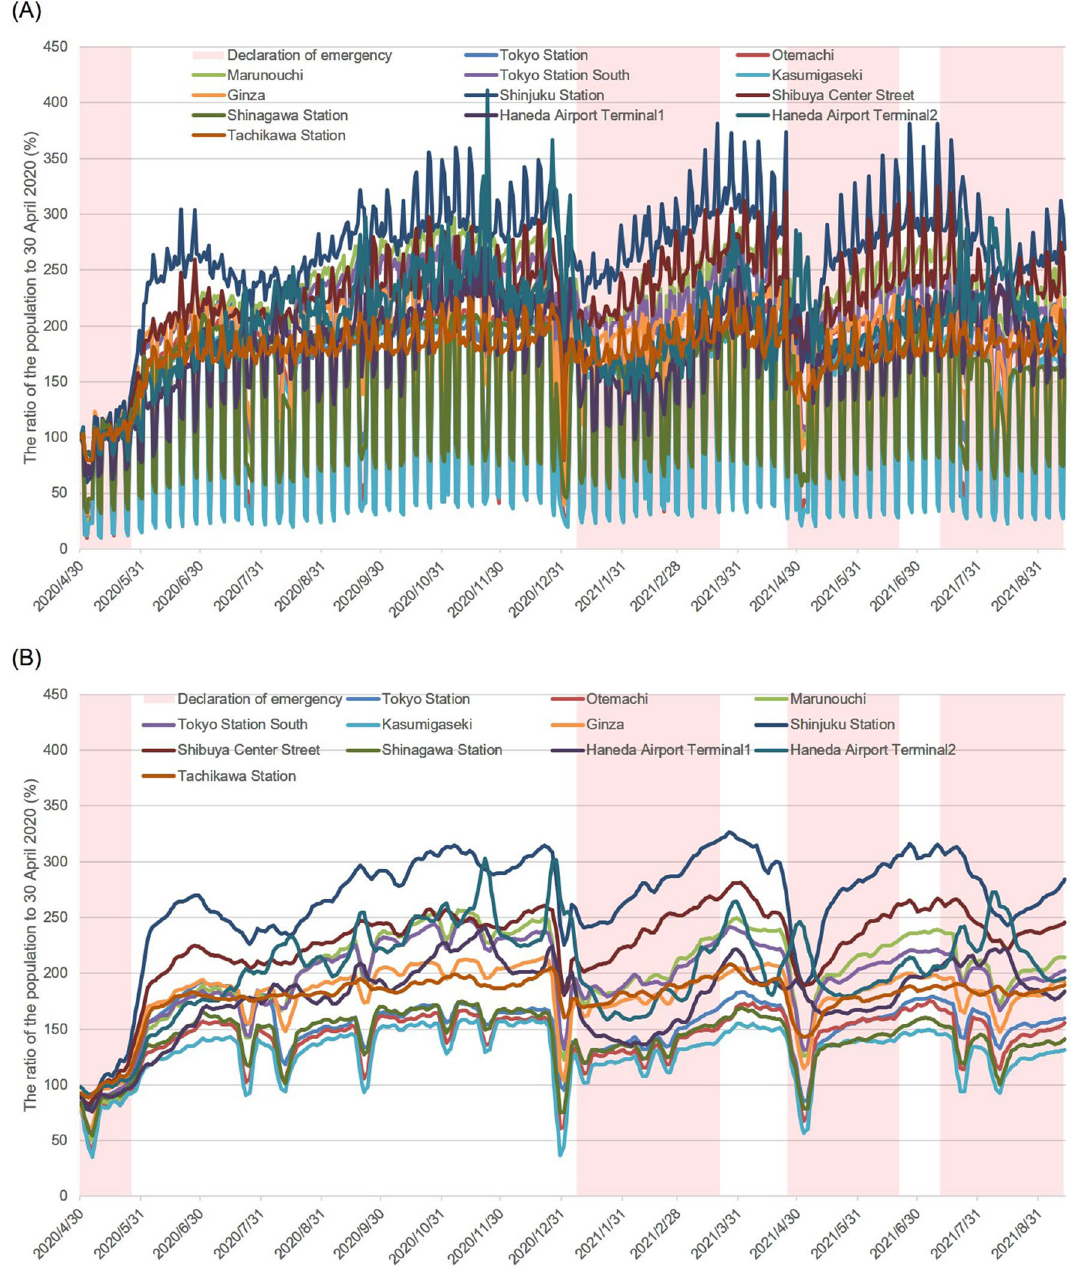
Figure 2. The ratio of the population at 12 sites and the period of emergency declaration. The ratio of the population to 30 April 2020 at 12 sites (i.e. Tokyo station, Otemachi, Marunouchi, Tokyo station south, Kasumigaseki, Ginza, Shinjuku Station, Shibuya Center Street, Shinagawa Station, Haneda Airport Terminal 1, Haneda Airport Terminal 2, and Tachikawa station) is shown. Raw data are shown in ( A ), and only the trend components are shown in ( B ). The periods of the emergency declaration are shown in